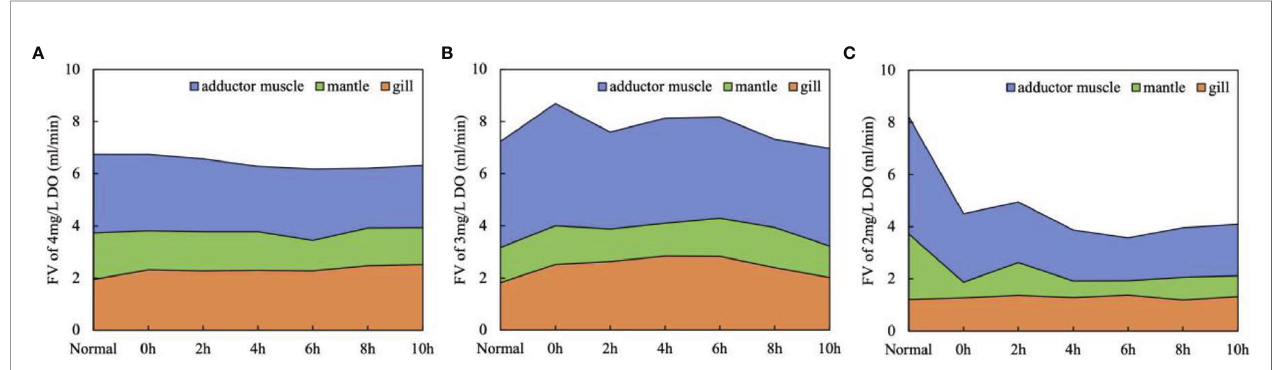
FIGURE 4 | The stacked line chart of FV changes in gill, mantle, adductor muscle and total under three hypoxia stress degrees [ (A) 4mg/L DO; (B) 3mg/L DO ; (C) 2mg/L DO ; means, n=5].